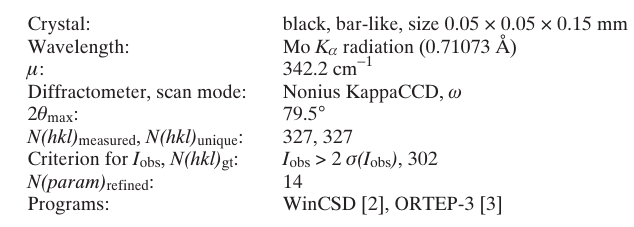
Table 1. Data collection and